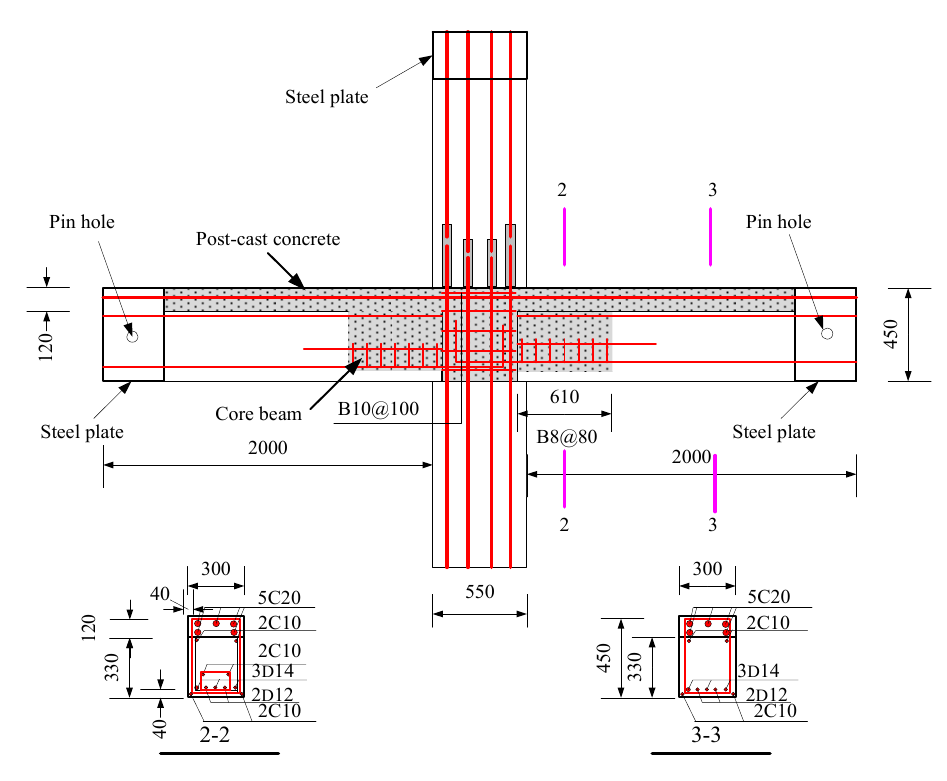
Figure 5. The assembly design details of YZ1 (Unit: mm).